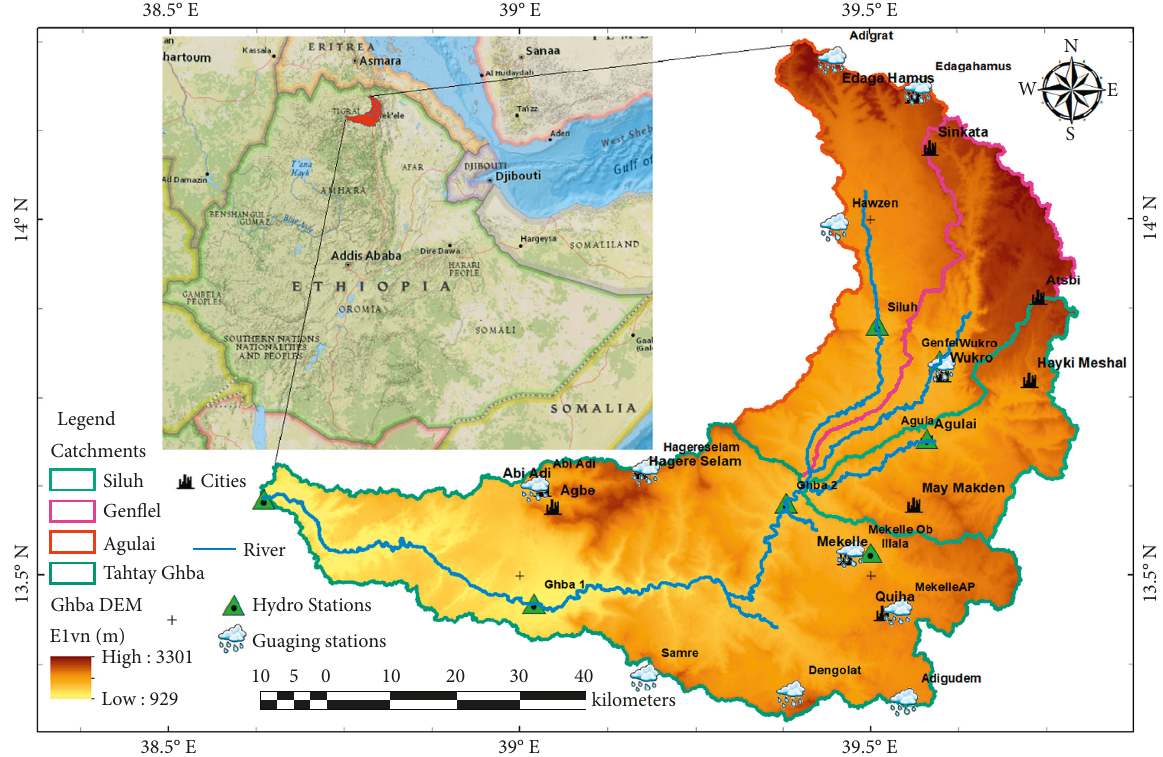
Figure 1: Location of the study